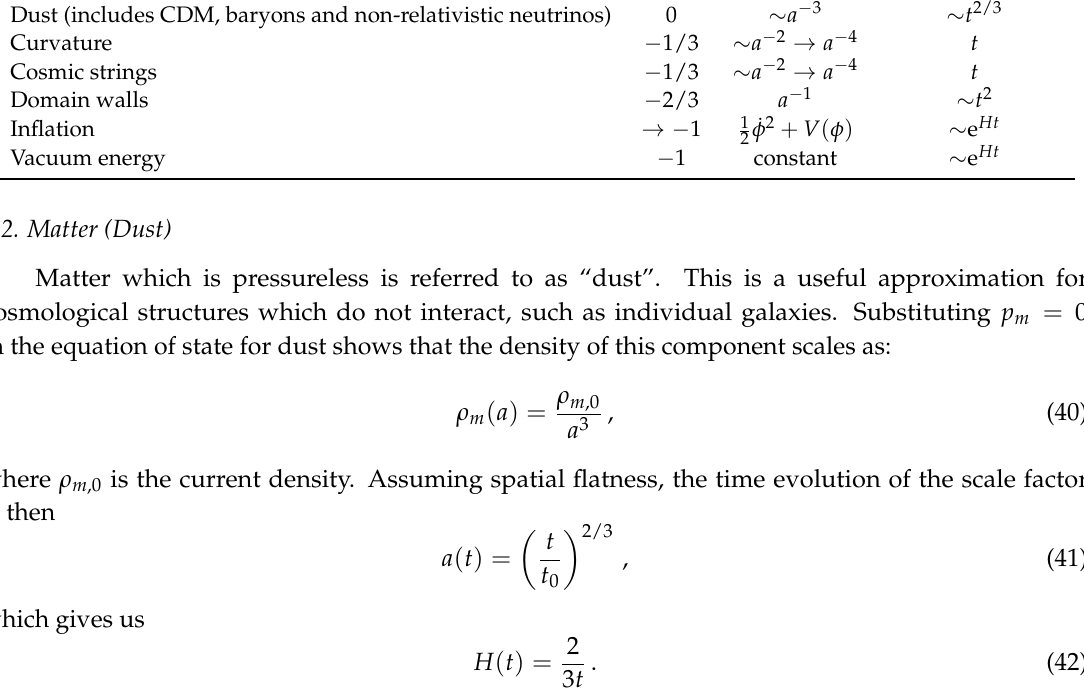
Table 2. The evolution of the various cosmological components. The quantities are the equation of p / ρ c 2 , the density ρ , the pressure p , and the scale factor a ( t ) . state w ≡ Component w ρ = a 3 ( 1 + w ) a ( t ) = t 2/3 ( 1 + w ) Radiation (photons and relativistic neutrinos) 1/3 Dust (includes CDM, baryons and non-relativistic neutrinos) 0 Curvature Cosmic strings Domain walls Inflation Vacuum